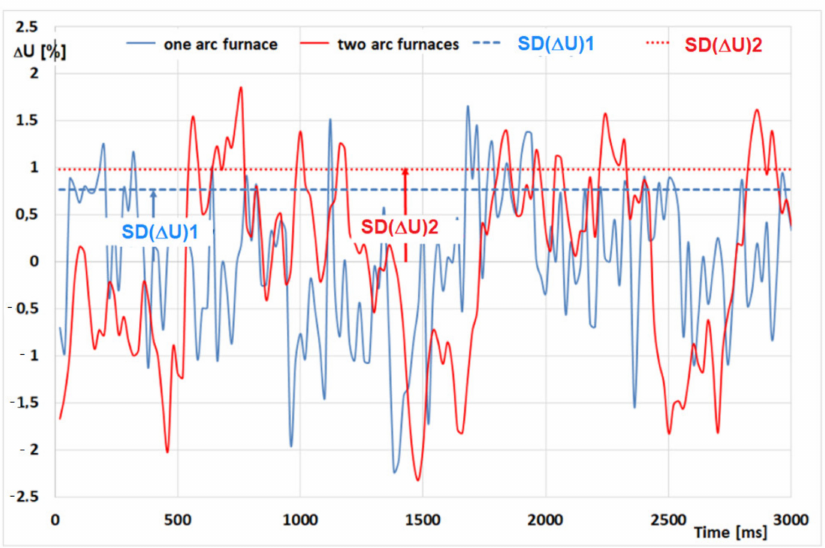
Figure 3. Voltage changes as a function of furnace current